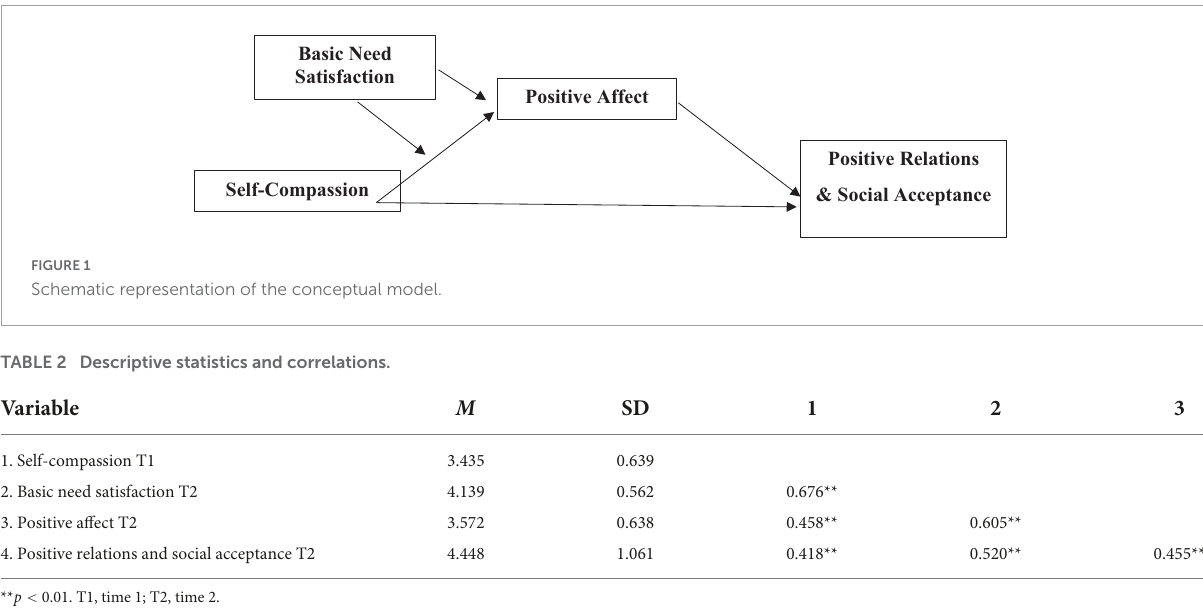
TABLE 3 Direct effects.